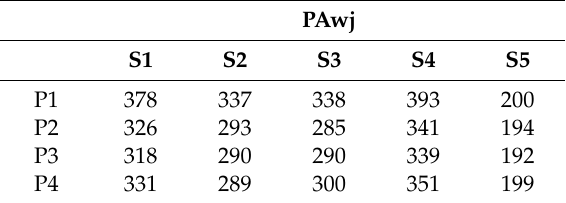
Table 5. Data to calculate the Bonferroni Probabilistic Operator (B-PO).